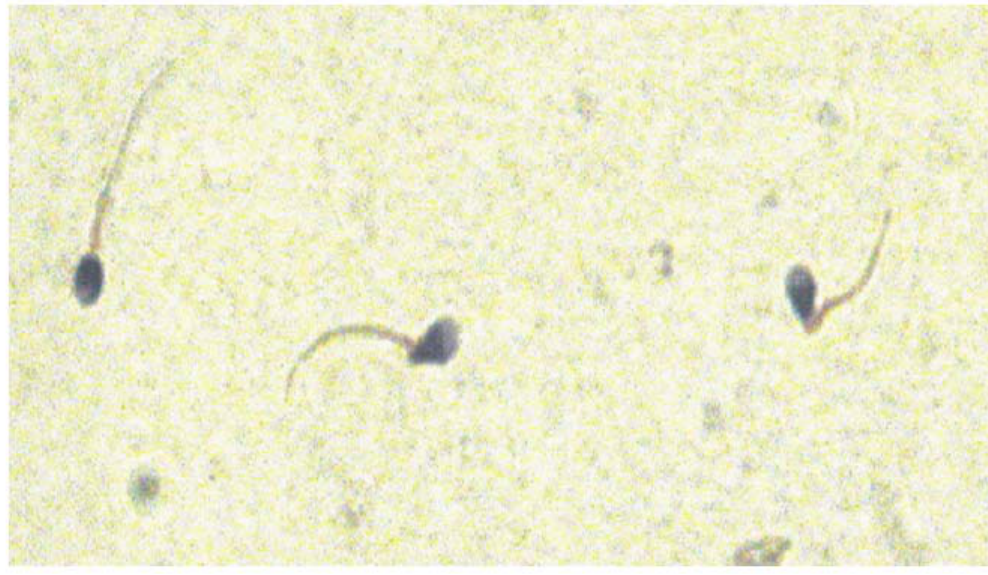
FIGURE 1. Short-tail spermatozoa.